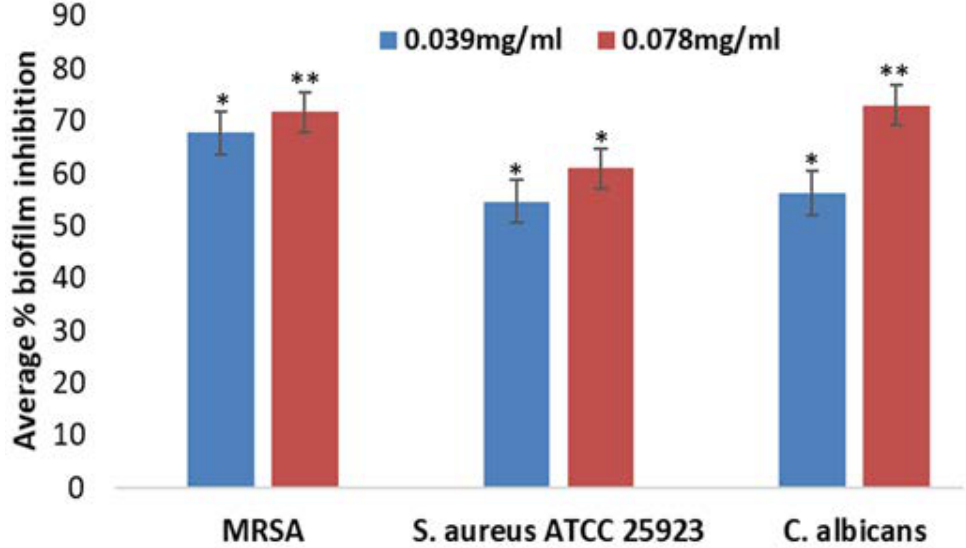
Figure 9. Inhibition of biofilm formation of MRSA, S. aureus , and C. albicans caused by AP-AgNPs treatment. The asterisks (**) represent the significance as p < 0.001 and asterisks (*) represent the significance as p < 0.01 against their control experiments by One-Way ANOVA-based Pairwise Multiple Comparison Procedures (Holm-Sidak method), whereas the overall significance level was